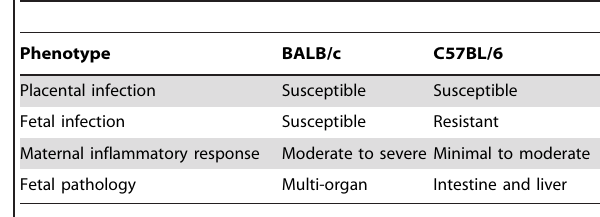
Table 3. Predominant BALB/c and C57BL/6 response profile to U. parvum intrauterine